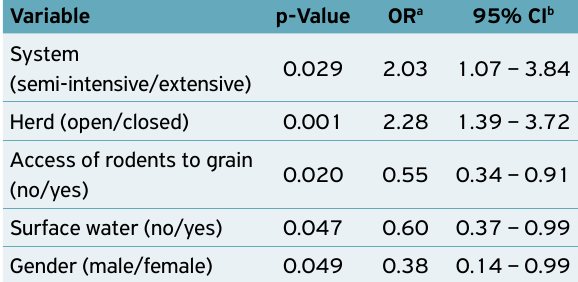
Table 2. Logistic regression of risk factor associated with Leptospira spp. infection among sheep in Pernambuco state,